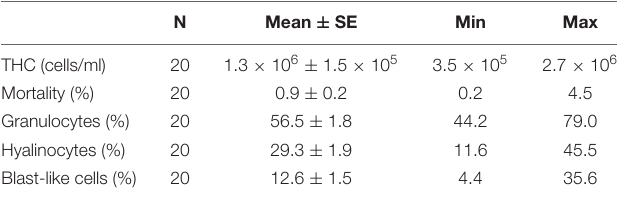
The oxidative capacity was significantly higher in granulocytes (6.4 × 10 4 A.U.) than hyalinocytes (3.2 × 10 4 A.U., Student’s t -test, P < 0.05, Figure 4B ). Granulocytes (1.7 × 10 5 A.U.) contained significantly more lysosomes than hyalinocytes (0.7 × 10 5 A.U., Student’s t -test, P < 0.05, Figure 4C